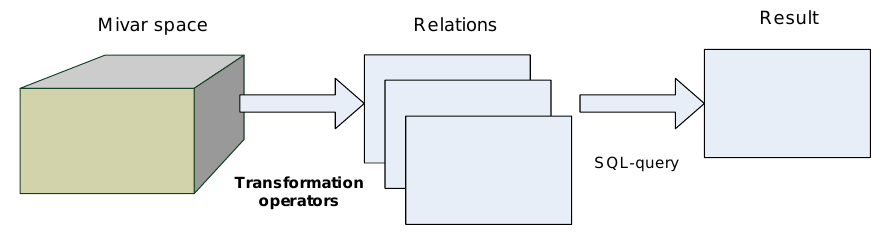
Fig. 5. The work scheme with multidimensional information